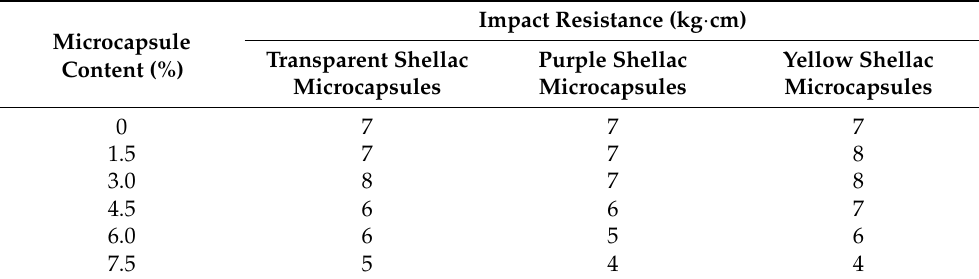
Table 8. The impact resistance of the coating on Beli wood with the content of different shellac core microcapsules in the